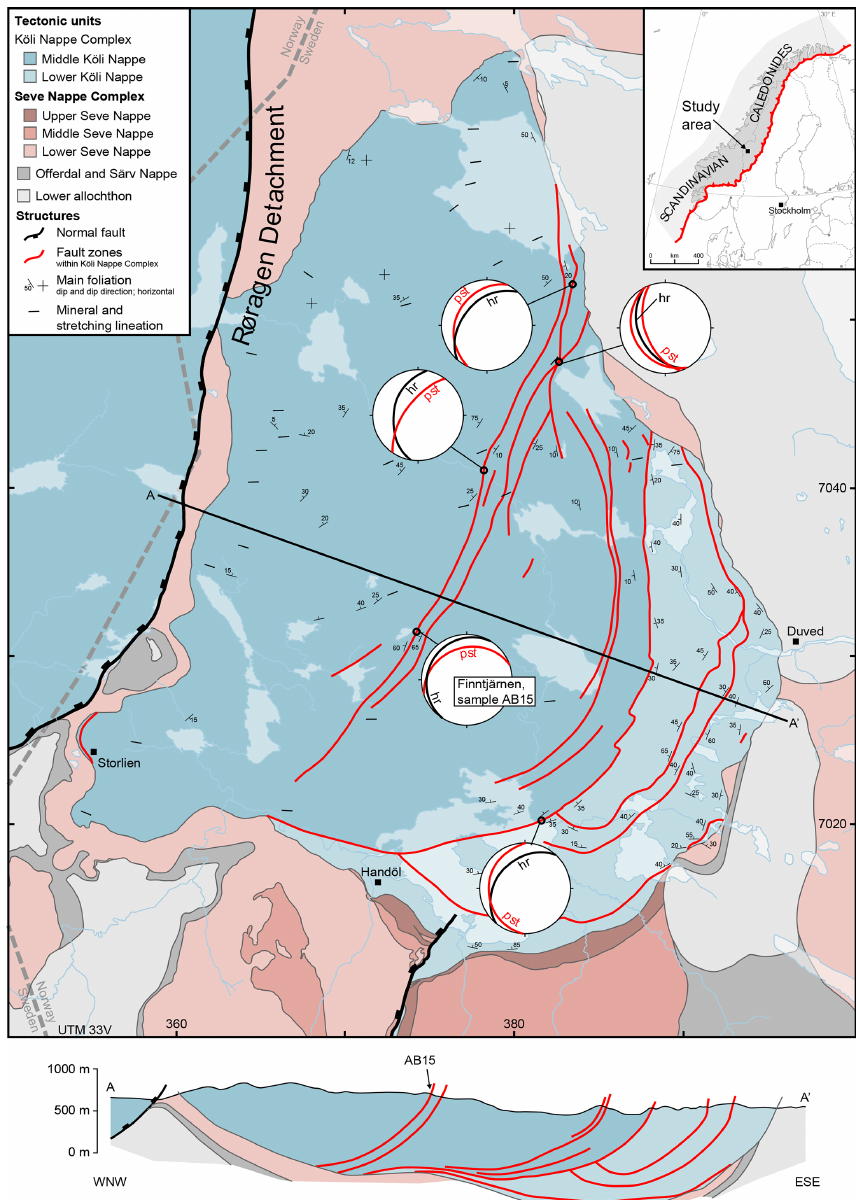
Figure 1. Geological map of the Tännforsen Synform and section A–A’ across it (modified after Beckholmen, 1984). Structural positions of tectonic units are indicated in the top left. Structurally lower faults are truncated by structurally higher faults within and beneath the Köli Nappe Complex. Lower-hemisphere equal-area nets show orientations of host rock schistosity (hr) subparallel to pseudotachylyte-bearing fault veins (pst) (data from this study and Bergman, 2017). The Røragen Detachment in the west cuts across all other units beneath it, illustrating that it developed structurally the